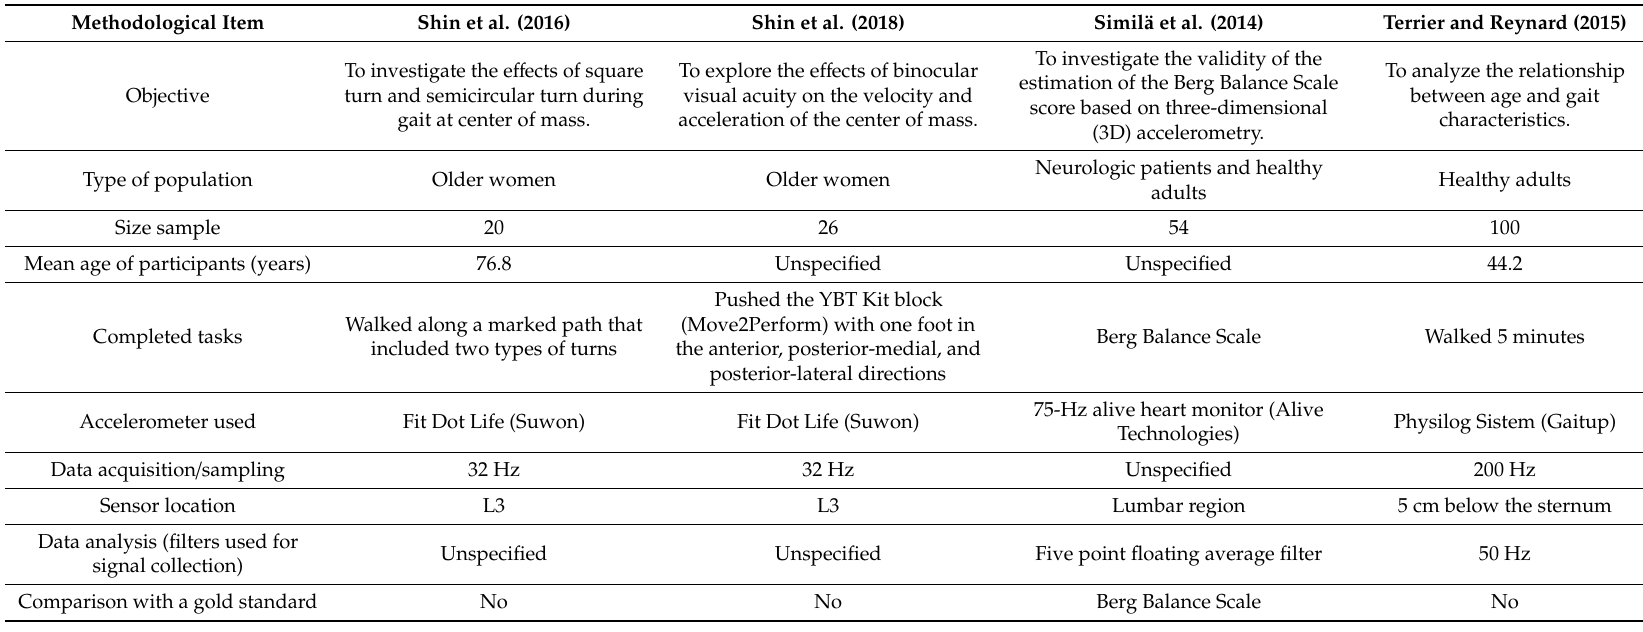
Table A7. Methodological details of the research analyzed.